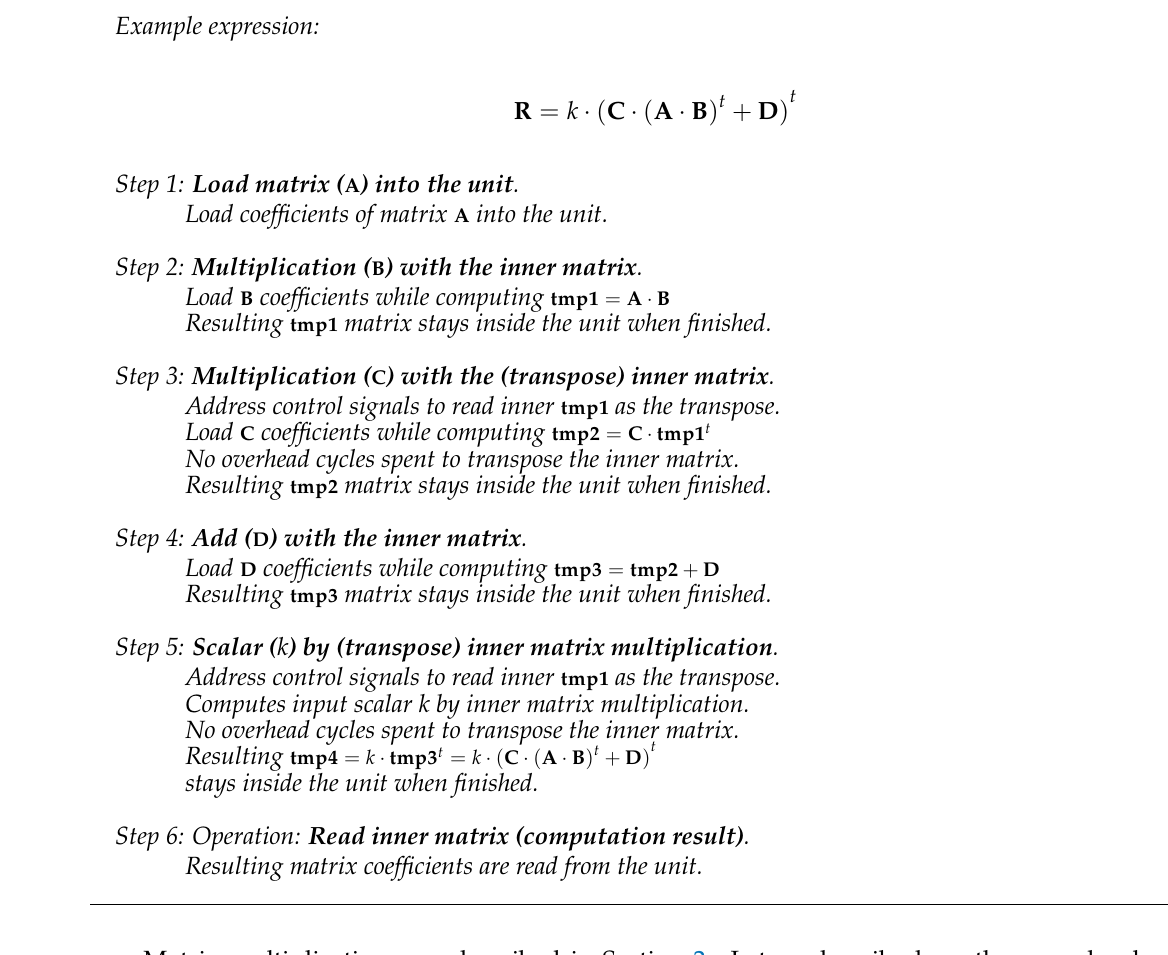
Algorithm 2 Use of the proposed matrix-computing unit to solve an example matrix expression. The sequence of matrix operations required to achieve the final result is